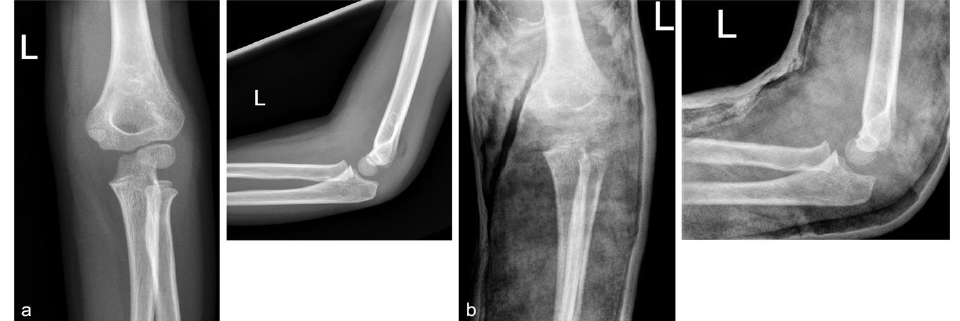
Figure 2. The course of a conservatively treated type II supracondylar fracture of the left (L) arm of a 5-year-old girl who fell from a standing position. ( a ) Initial anterior – posterior (a.p.) and lateral X-rays showing a type II fracture according to the Von Laer classification. ( b ) A.p. and lateral X-rays within the upper-arm cast (for three weeks) showing the fracture in an unchanged position (approximately 4 days after injury for exclusion of a secondary dislocation). Patient presented full range of motion and no deficits two weeks after cast removal.